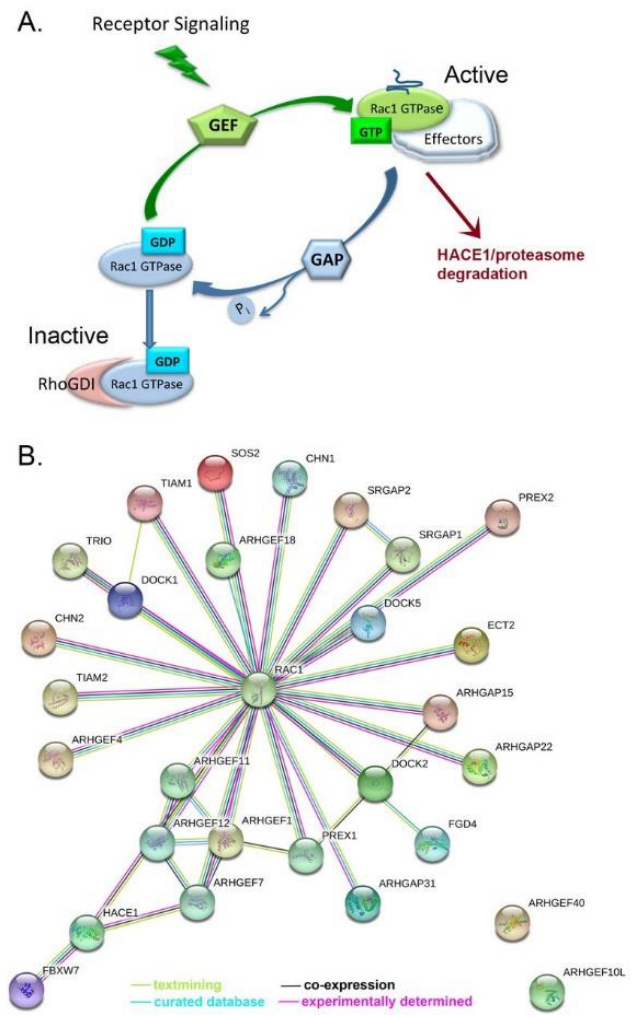
Figure 3. Rac1 Regulatory Network in Ovarian Cancer. Rac1 integrates signals downstream of tyrosine kinase receptors, adhesion molecules and G-protein coupled receptors and has nuclear functions. ( A ) There are over 40 GEF and GAP proteins involved in the regulation of Rac1 activity through the stimulation of nucleotide binding (GEFs) and hydrolysis (GAPs). Activated Rac1 binds to effectors that recognize the unique conformation of the GTP-bound GTPase and mediate downstream physiologic responses to receptor signaling. Activated Rac1 is ubiquitinated by HACE1 or FBXW7 and targeted for proteasomal degradation, further controlling protein levels and activity. ( B ) Twenty-six Rac1 GEF and GAP proteins, HACE1 and FBXW7 ubiquitin ligases have somatic mutations in serous ovarian cancer patient samples. String network analysis places Rac1 at the core with a large array of close functional associations with Rac1 regulatory proteins whose functions in ovarian cancer largely remain to be determined.